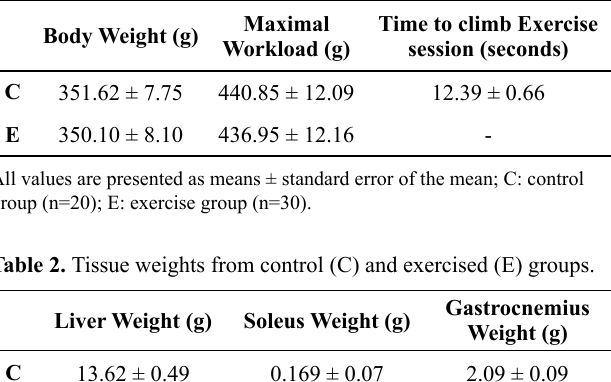
Table 1. Body weight and maximal workload.